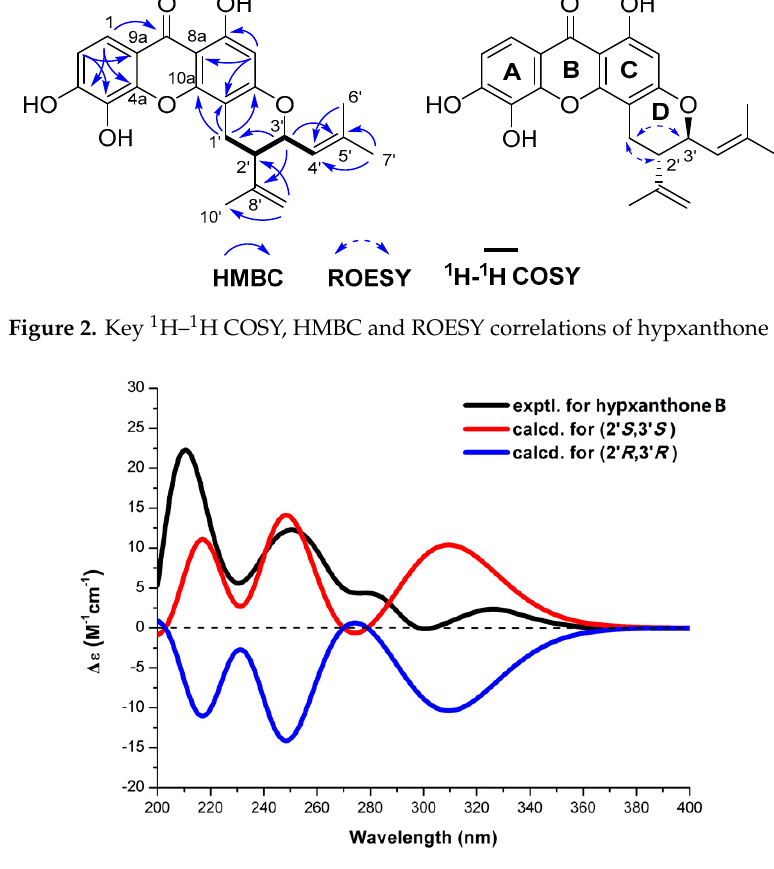
Figure 3. Comparison of experimental (black line) and calculated (red and blue lines) ECD spectra of hypxanthone B.